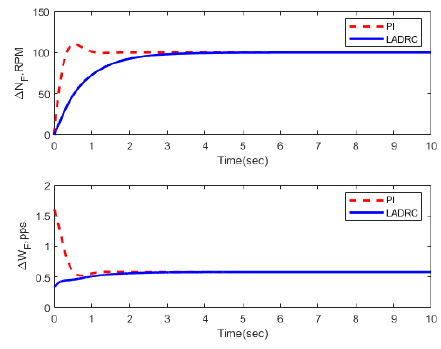
Figure 20. Step response of FC11.